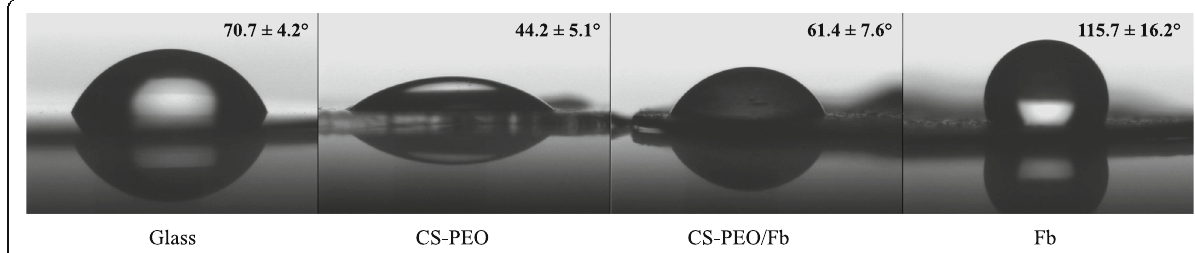
Fig. 5 Behavior of deionized water on the surface of a glass substrate, CS-PEO, CS-PEO/Fb, and Fb